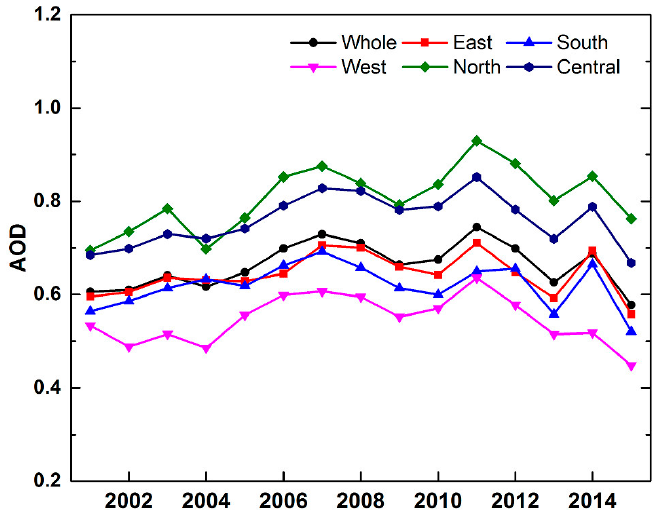
Figure 6. AOD time series over eastern, southern, western, northern, and central parts of central China and entire central China during 2001–2015.